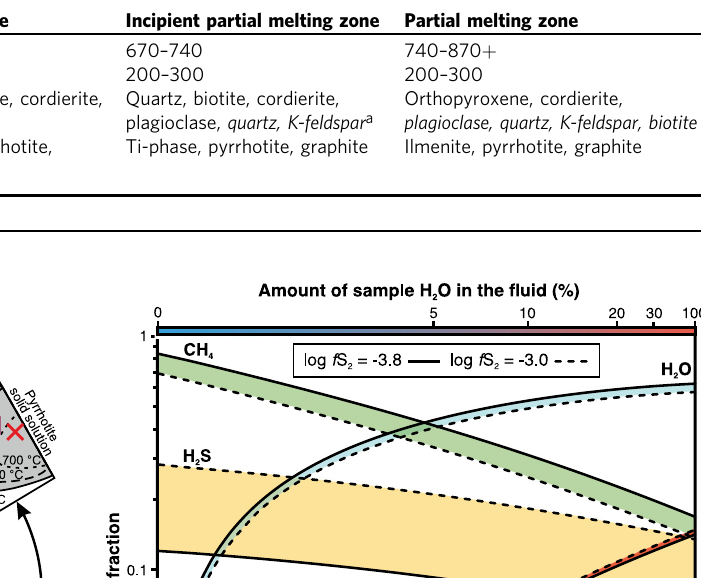
Table 2 Typical phase assemblages from the pristine parts of the Virginia Formation and from the different zones in the contact aureole 31 .